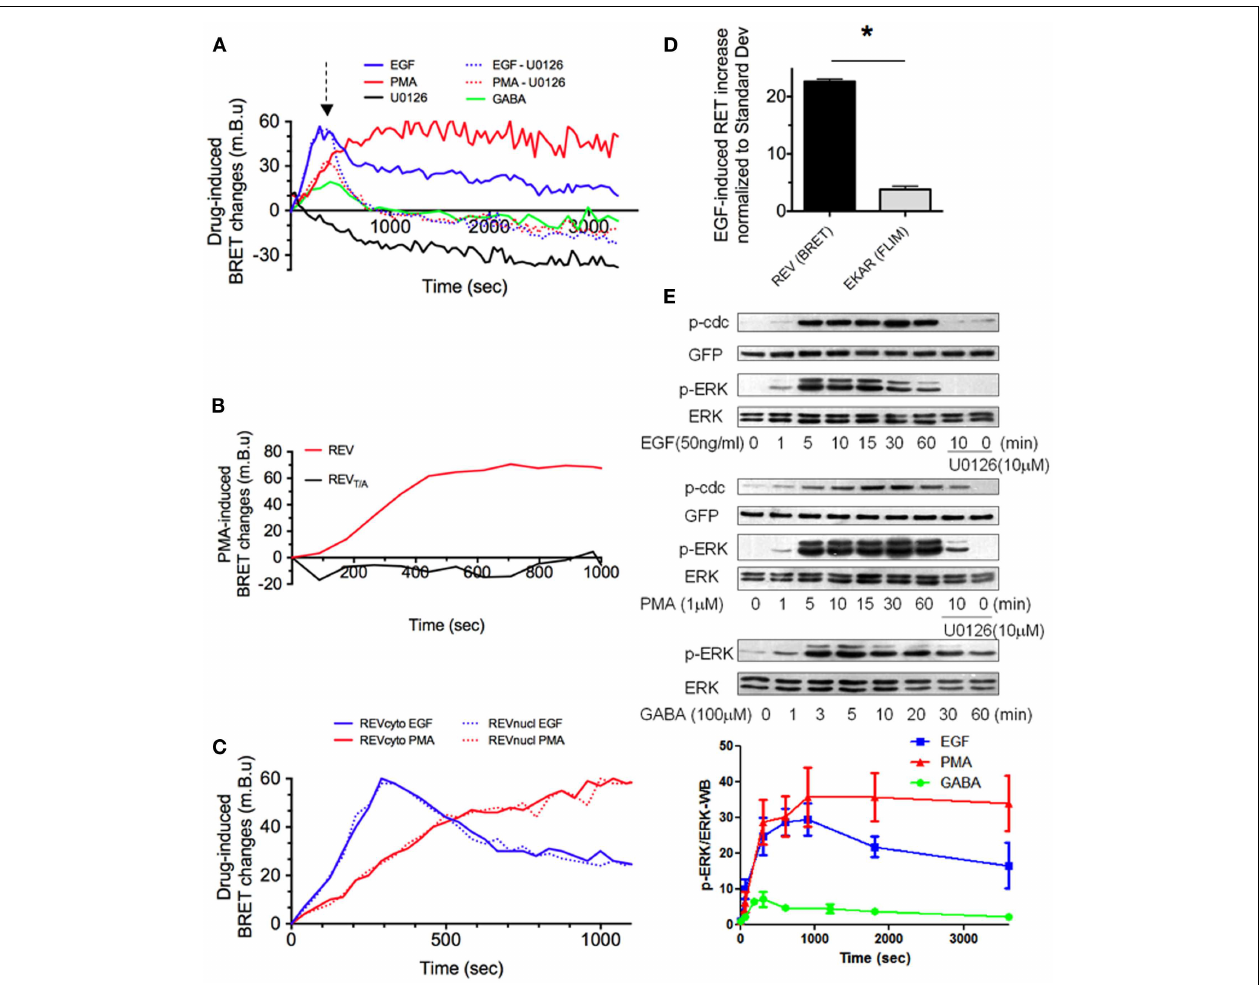
induced by PMA (red) or EGF (blue) were measured in the cytosol (full lines) or nucleus (dotted lines). (D) Sensitivities of EKAR (FRET/FLIM-based reporter) and REV (BRET-based reporter) were compared by normalizing the EGF-effect to the standard deviation in their respective technology. (E) ERK, phospho-ERK (p-ERK), REV (GFP), and phospho-REV (p-cdc) staining quantified by western blot in HEK293T cells transfected (GABA – green line) or not (EGF and PMA conditions, blue and red line) with GB1 and GB2 subunits of GABA-B receptor before and up to 60min after drug application. When specified, following 10min of EGF or PMA incubation, U0126 was added for 50min. p-ERK/ERK ratio were calculated in each column and normalized to the p-ERK/ERK ratio measured before stimulation ( t = 0). Each point of the graph below represents the mean ± SEM obtained from three individual experiments, for each time